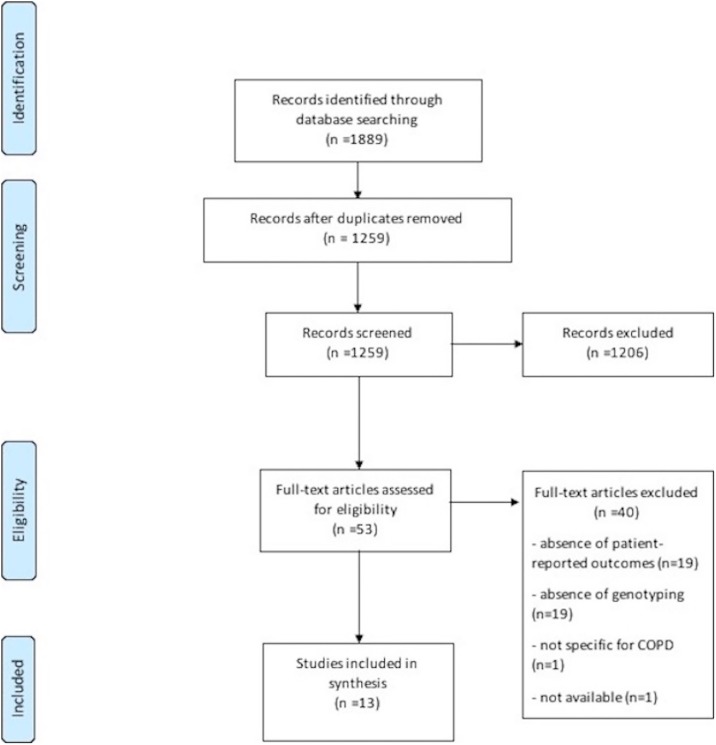
PRISMA flow diagram.